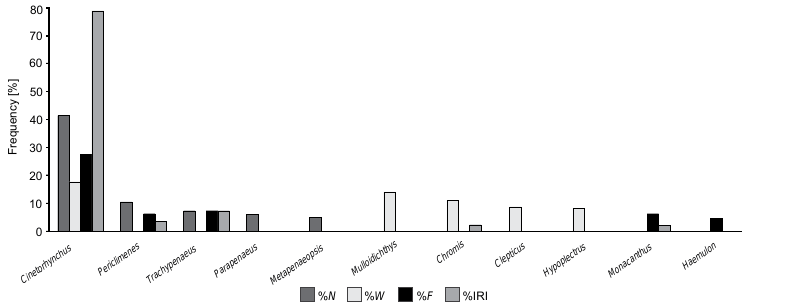
Fig. 7. Diet composition of red lionfi sh, Pterois volitans , during the rainy season; % N = percentage by number, % W = percentage by weight, % F = frequency of occurrence, %IRI = index of relative importance %IRI